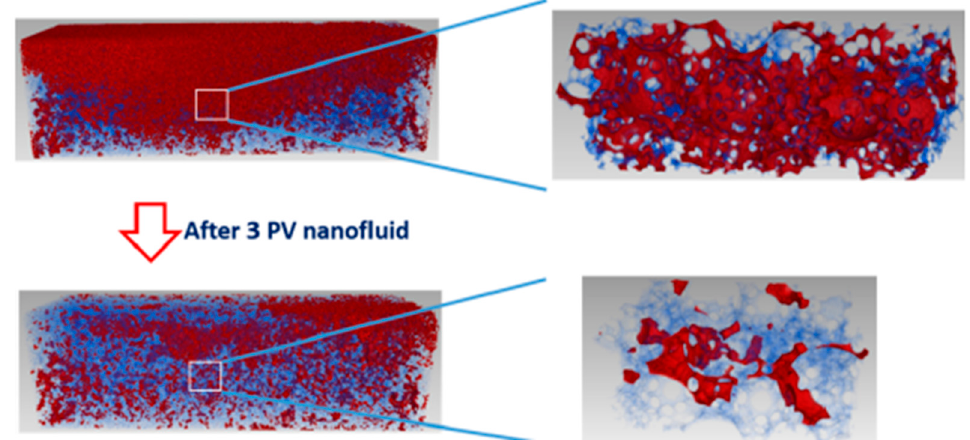
Figure 17. Oil blobs before and after 3 PV nanofluid flooding at Ca = 10 − 7 . Reprinted with permission from [57]. Copyright 2016 American Chemical Society.